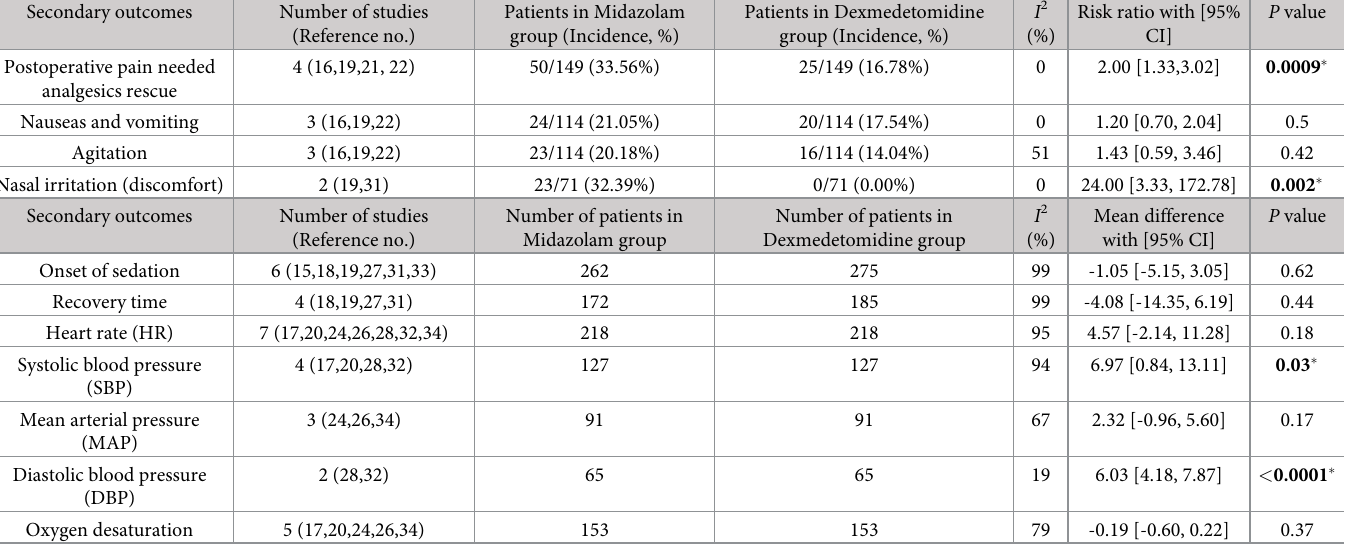
Table 2. Secondary outcomes.